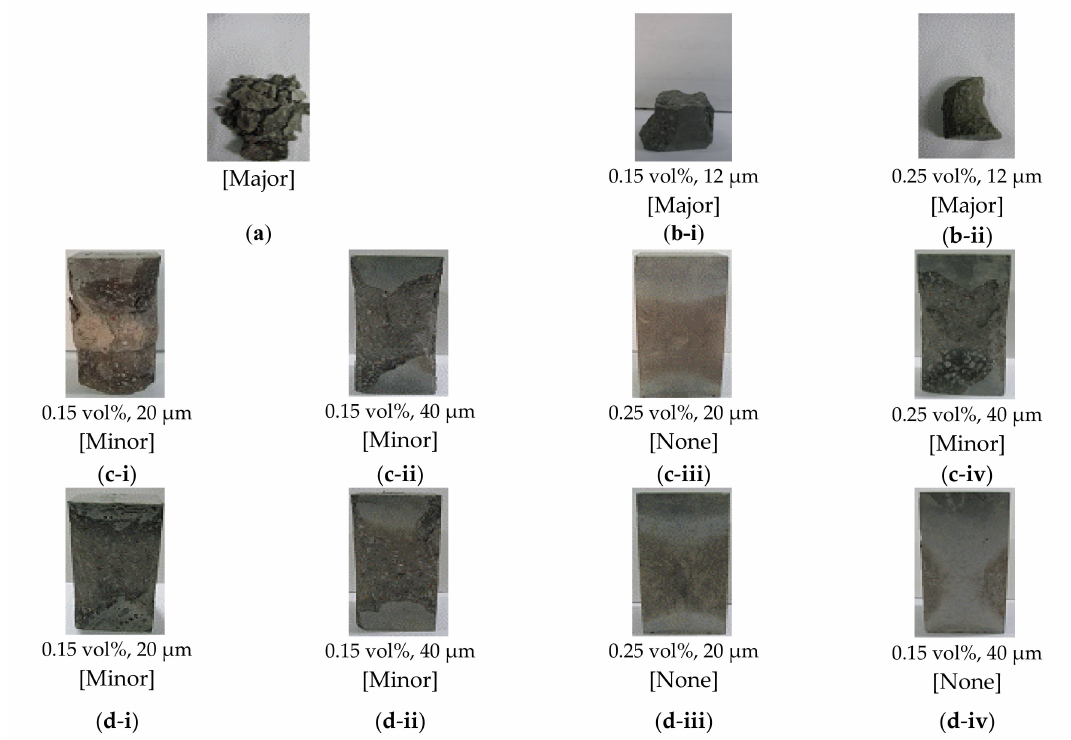
Figure 9. Spalling grades and images of the concrete specimens with additive fibers: ( a ) Plain; ( b ) polyethylene (PE); ( c ) polypropylene (PP); ( d ) nylon (NY).